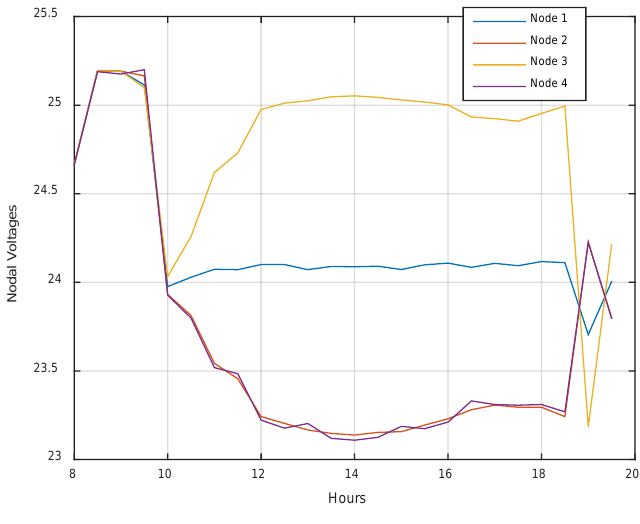
Figure 8. Result of the nodal voltages.